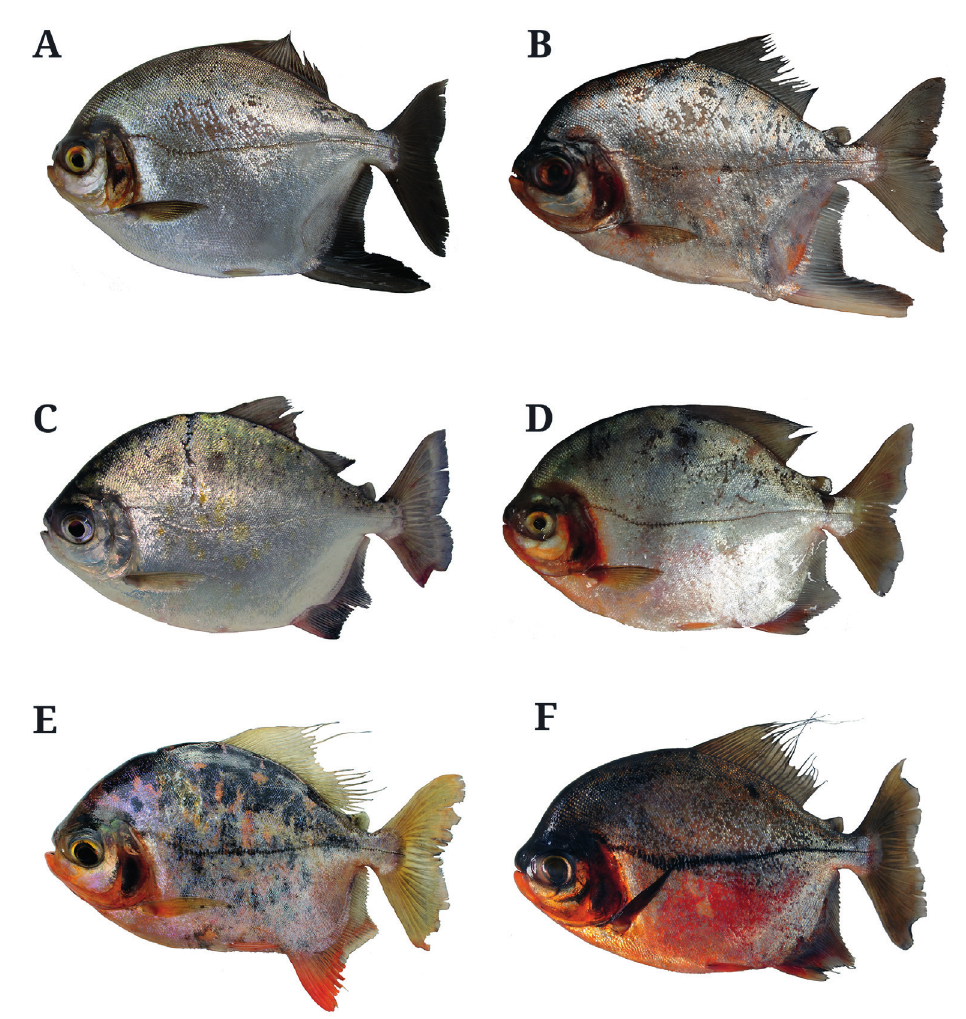
FIGURE 4 | Freshly collected Myloplus nigrolineatus with different color patterns. A. INPA 23312, 182.0 mm SL, female, lago Mabi, São Gabriel da Cachoeira, Amazonas; B. INPA 53281, 170.7–180.3 mm SL, female, rio Negro nearby Manaus, Amazonas; C. INPA 23446, 160.0 mm SL, male, tissue voucher CTGA 15401, Tapajós Itaituba, Pará; D. INPA 46279, 172.3 mm SL, male, tissue voucher CTGA 12201 (GenBank accession MG752197), rio Branco, boundary between Caracaraí and Rorainópolis, Roraima; E. INPA 58772, 189.3 mm SL, male, rio Purus, Tapauá, Amazonas; F. INPA 52505, 186.4 mm SL, male, tissue voucher CTGA 12329 (MG752209), rio Negro nearby Barcelos,